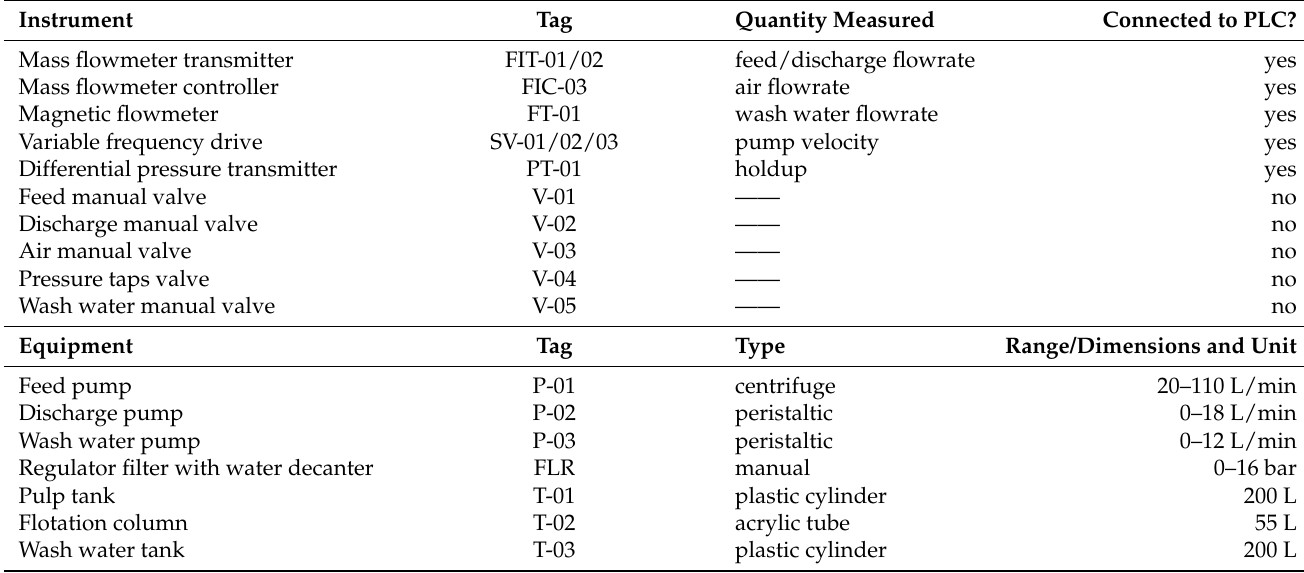
Table 2. Legend of the P & ID schematic (Figure 2, right).